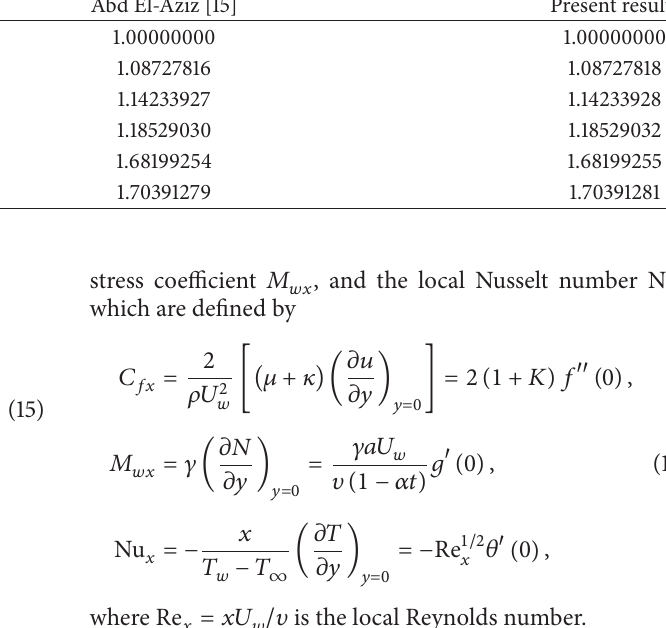
Table 1: Comparison of −𝜃 󸀠 (0) for different values of 𝐴 and 𝜉 when 𝐾 = Ec = 𝑅 = 0 and Pr = 1.